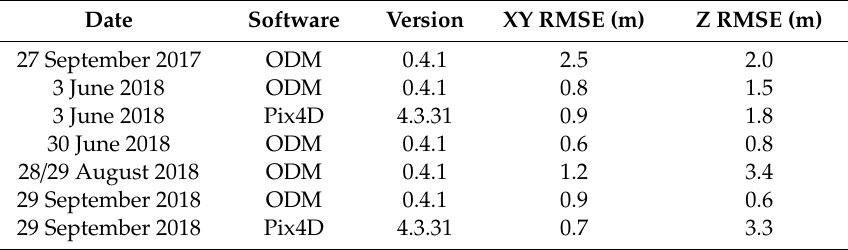
Table A2. XY o ff set between the UAV-based orthophotos and the SwissImage from 2014 measured at nine objects in the glacier forefield (Figure 9a, Table S3). Z o ff set between the UAV-based DSMs and swissALTI3D from 2010 within a reference area outside the glacier (Figure